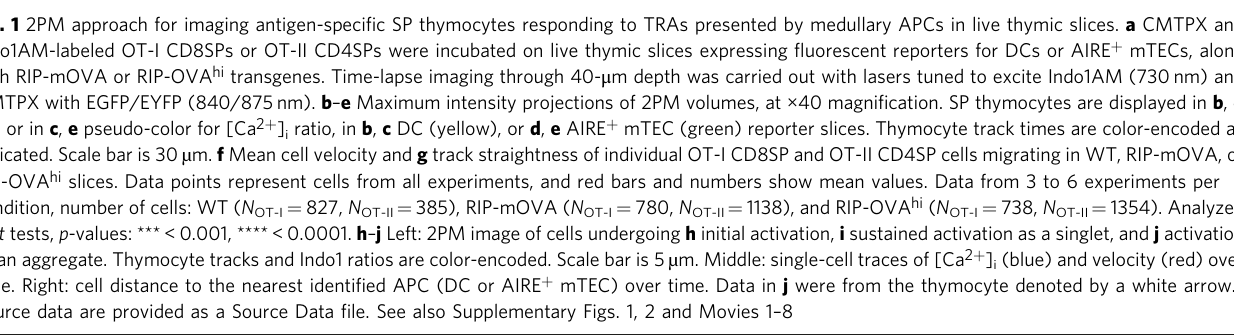
Fig. 1 2PM approach for imaging antigen-speci fi c SP thymocytes responding to TRAs presented by medullary APCs in live thymic slices. a CMTPX and Indo1AM-labeled OT-I CD8SPs or OT-II CD4SPs were incubated on live thymic slices expressing fl uorescent reporters for DCs or AIRE + mTECs, along with RIP-mOVA or RIP-OVA hi transgenes. Time-lapse imaging through 40- μ m depth was carried out with lasers tuned to excite Indo1AM (730 nm) and CMTPX with EGFP/EYFP (840/875nm). b – e Maximum intensity projections of 2PM volumes, at ×40 magni fi cation. SP thymocytes are displayed in b , d red or in c , e pseudo-color for [Ca 2 + ] i ratio, in b , c DC (yellow), or d , e AIRE + mTEC (green) reporter slices. Thymocyte track times are color-encoded as indicated. Scale bar is 30 µ m. f Mean cell velocity and g track straightness of individual OT-I CD8SP and OT-II CD4SP cells migrating in WT, RIP-mOVA, or RIP-OVA hi slices. Data points represent cells from all experiments, and red bars and numbers show mean values. Data from 3 to 6 experiments per condition, number of cells: WT ( N OT-I = 827, N OT-II = 385), RIP-mOVA ( N OT-I = 780, N OT-II = 1138), and RIP-OVA hi ( N OT-I = 738, N OT-II = 1354). Analyzed by t tests, p -values: *** < 0.001, **** < 0.0001. h – j Left: 2PM image of cells undergoing h initial activation, i sustained activation as a singlet, and j